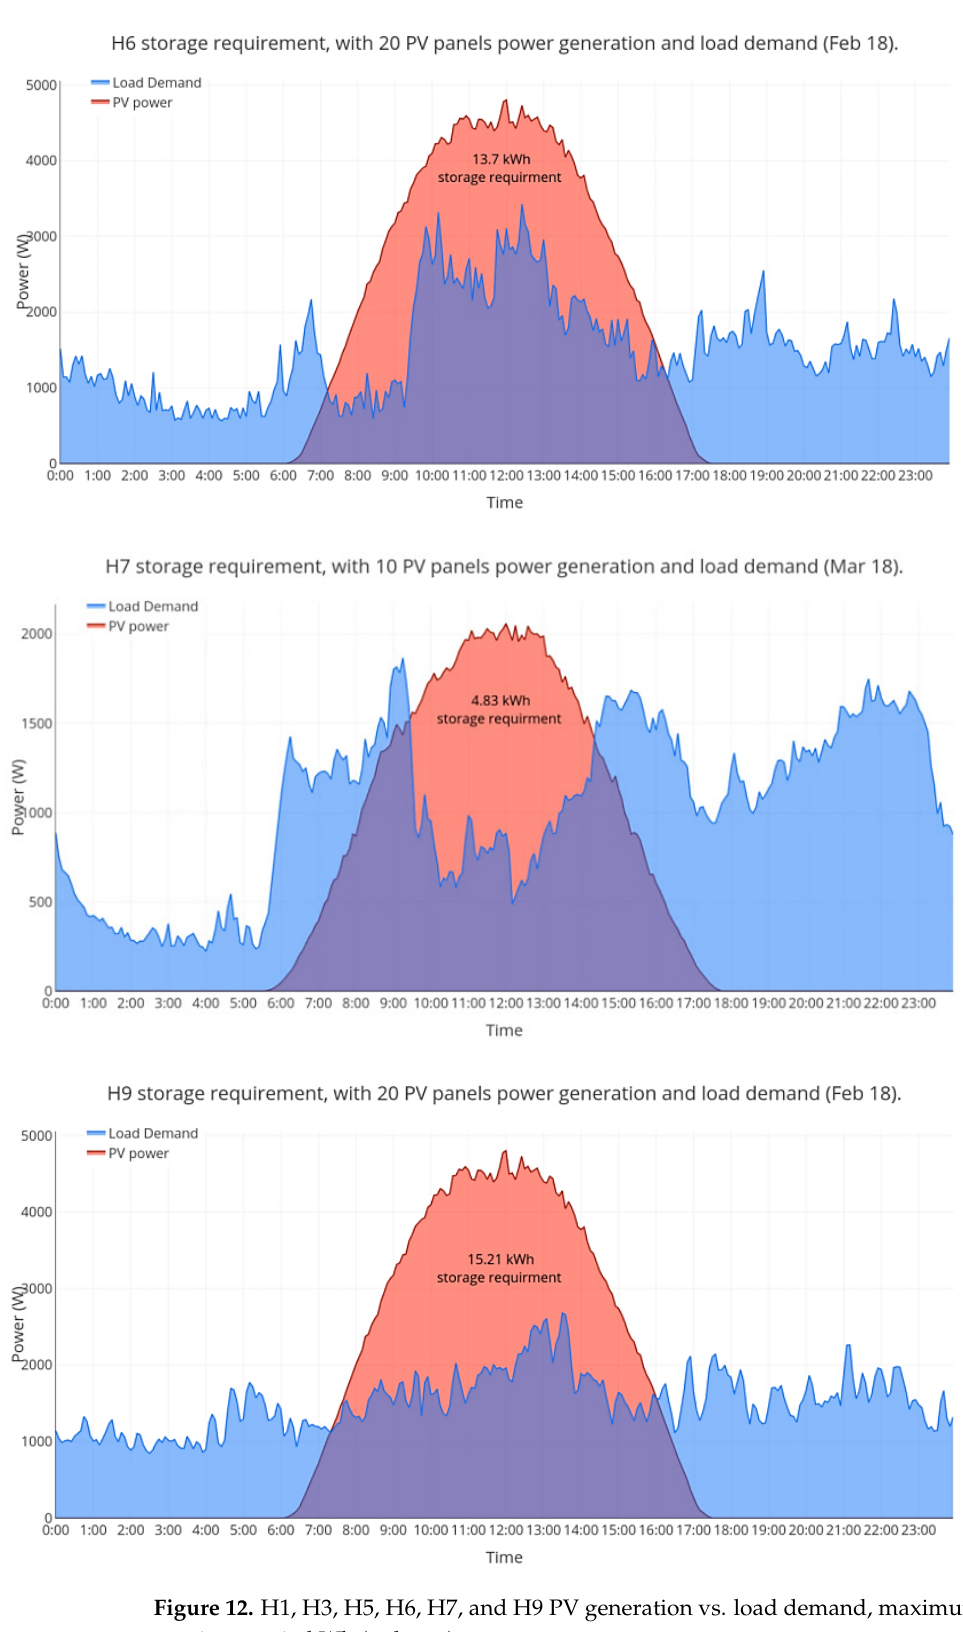
Figure 12. H1, H3, H5, H6, H7, and H9 PV generation vs. load demand, maximum energy storage requirement in kWh (red area).